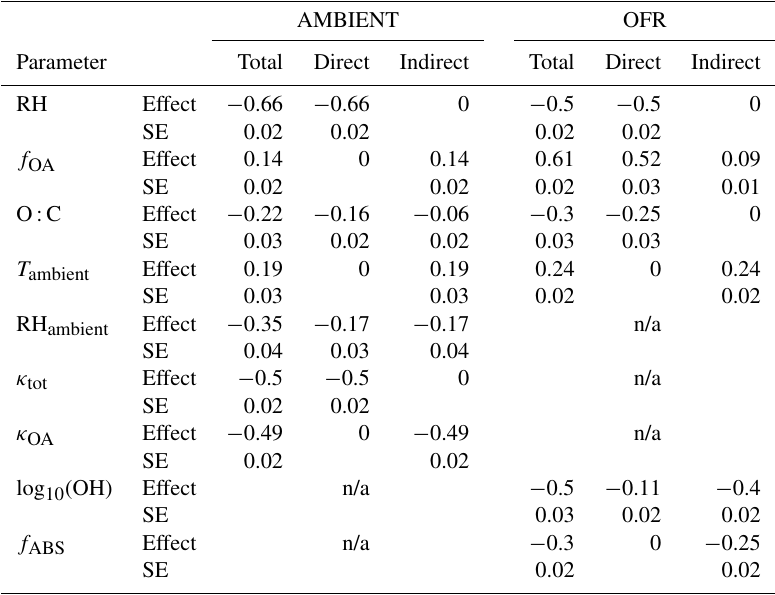
Table 2. Standardized effects (direct, indirect and total) on BF based on the SEM model performed for ambient data (Fig. 4) and OFR data (Fig. 5). Effects are standardized (i.e., scaled to follow normal distribution with zero mean and variance of unity) in order to compare parameter values that are measured on quite different